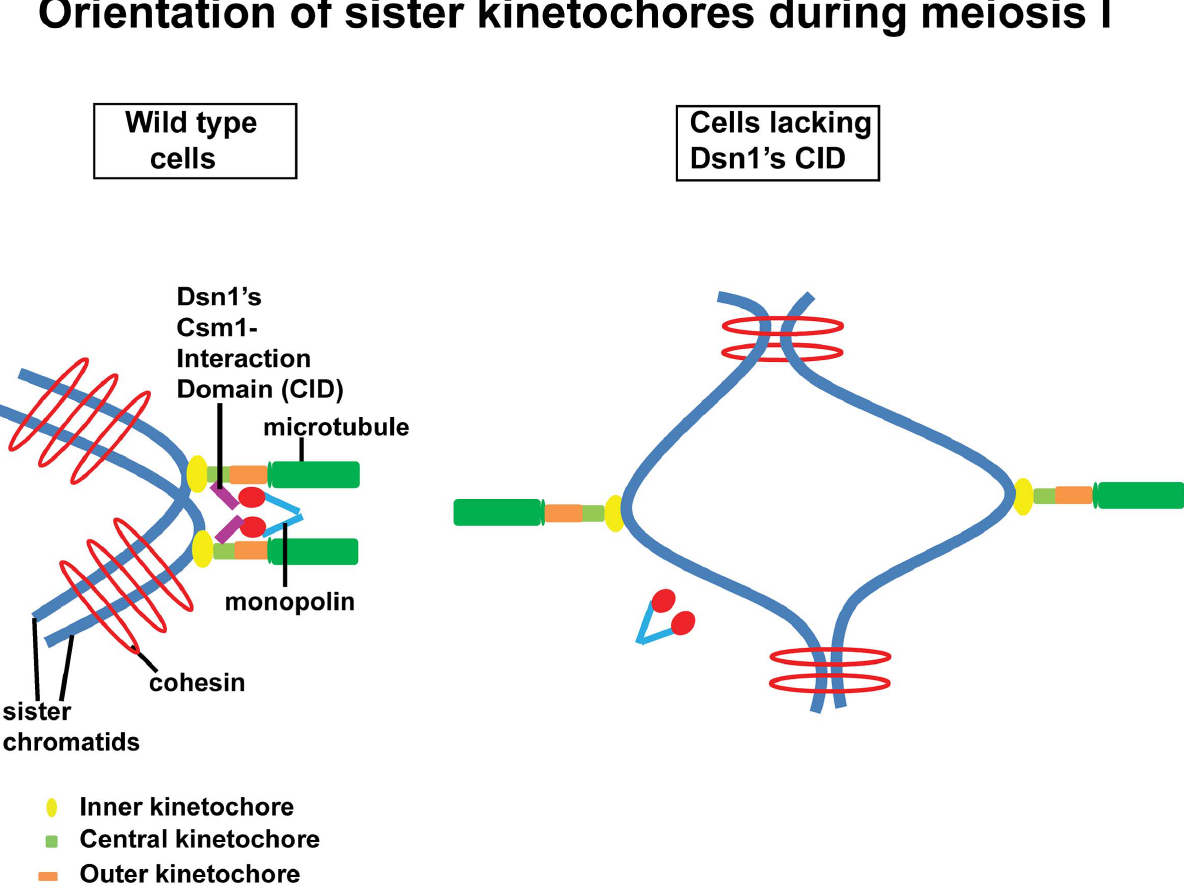
Figure 6. Role of the CID in monopolar attachment of sister kinetochores during meiosis I. Kinetochores are composed of three layers namely inner (yellow oval), central (green rectangle) and outer (orange rectangle). They are assembled at centromeres on sister chromatids (in blue). The outer kinetochore interacts with the growing ends of microtubules (in green). In wild type cells, monopolar attachment is achieved by interaction of the Csm1-Interaction Domain (purple) in Dsn1 (a subunit of the central kinetochore MIND complex) with the globular domain of Csm1 (red), a monopolin (V-shaped structure in blue) subunit. In cells expressing a form of Dsn1 lacking the Csm1-Interaction Domain, monopolins fail to bind to kinetochores and consequently the sister kinetochores are